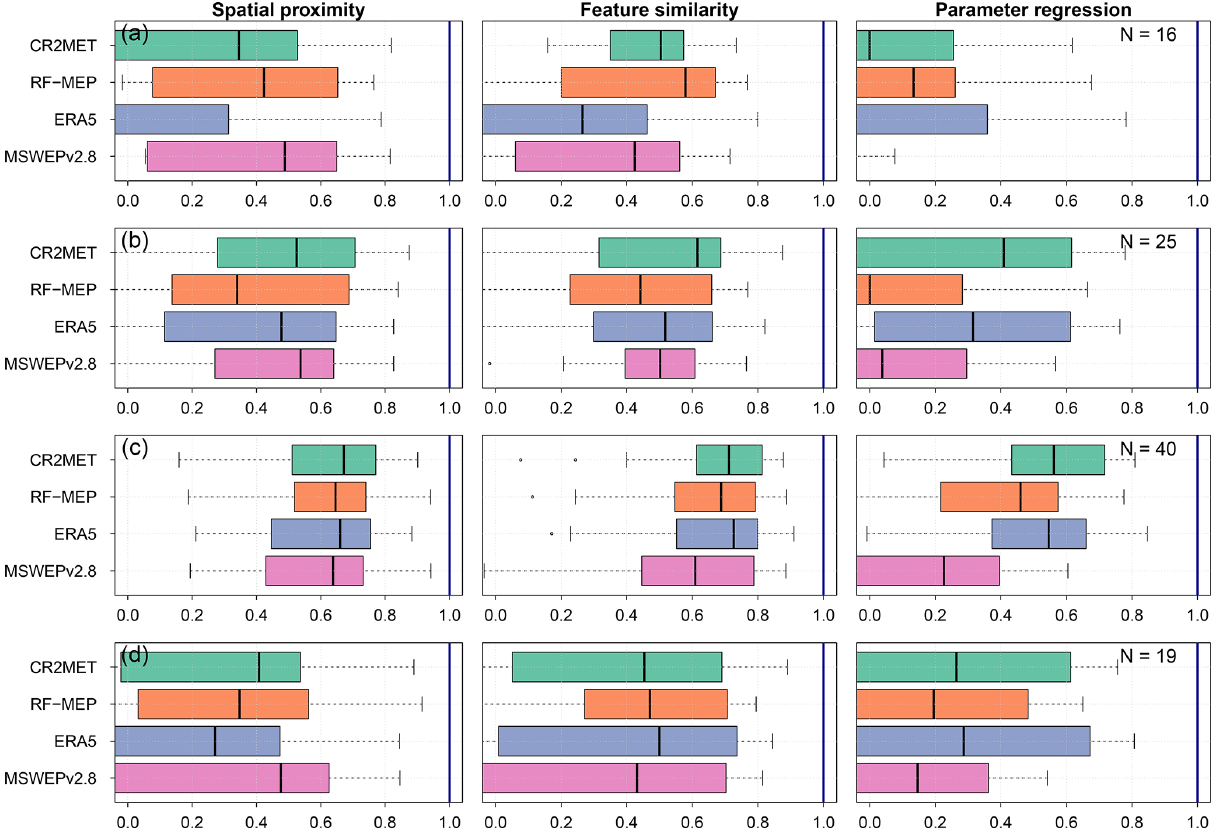
Figure 9. Performance of regionalisation methods for calibration (2000–2014) according to the hydrological regime: (a) snow-dominated,